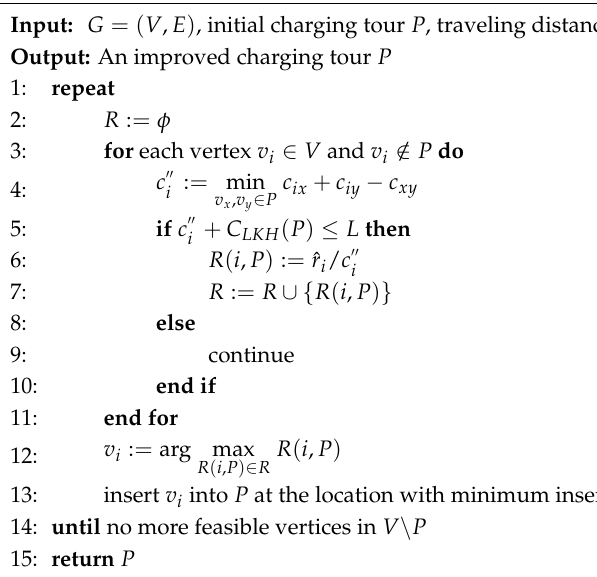
Algorithm 3. Tour